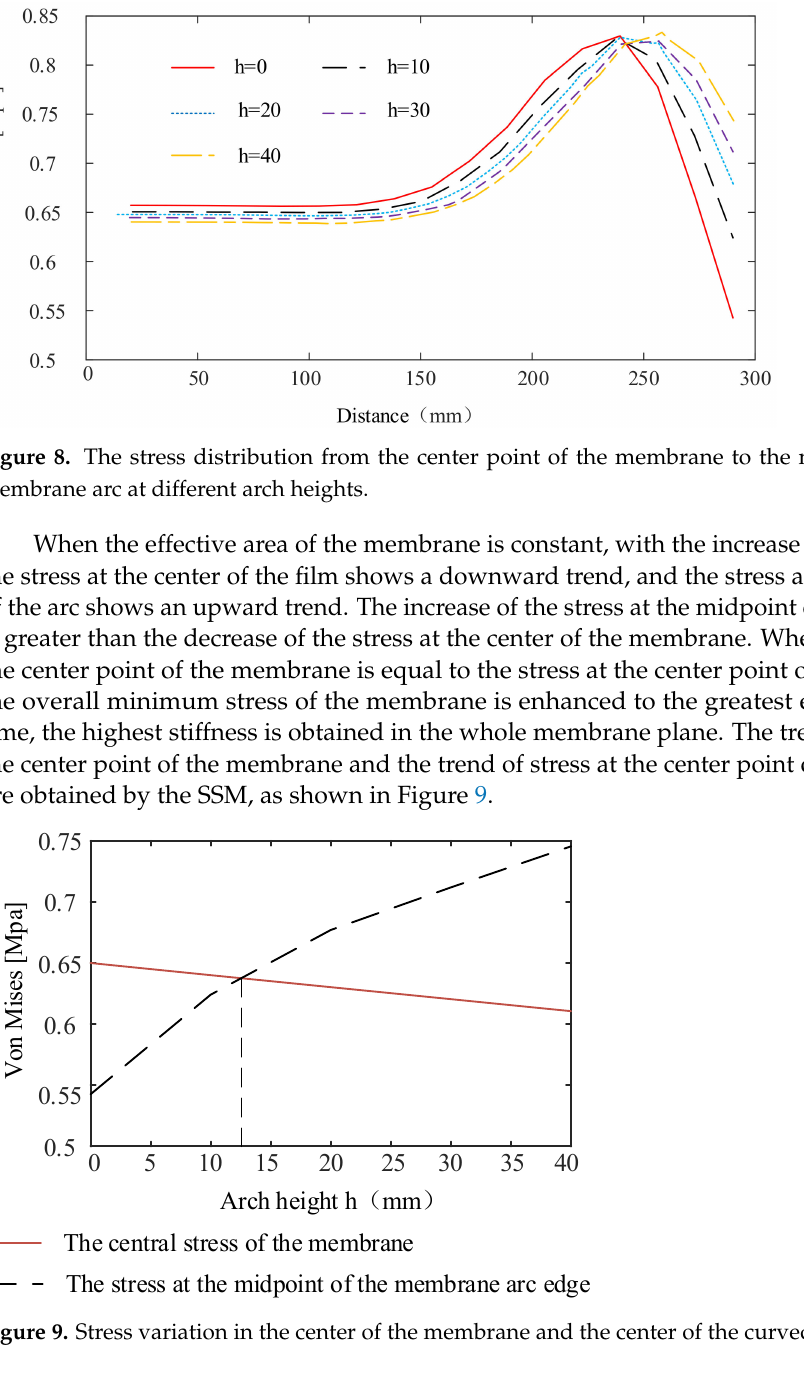
Figure 9. Stress variation in the center of the membrane and the center of the curved edge. When the two figures intersect at a single point, the stress at the center point of the membrane is equal to the stress at the center of the arc edge. The minimum stress in the whole membrane plane reaches the maximum value, in which the peripheral size of the ortho-polygon membrane only increases by 4.6%, but the minimum stress on the membrane surface is increased by 18.52%. For any orthogonal polygon structure, the law of stress propagation is the same, and the SSM can obtain the stresses at each point. According to the intersection point of the figure, the arch height corresponding to the maximum stiffness of the membrane is determined.